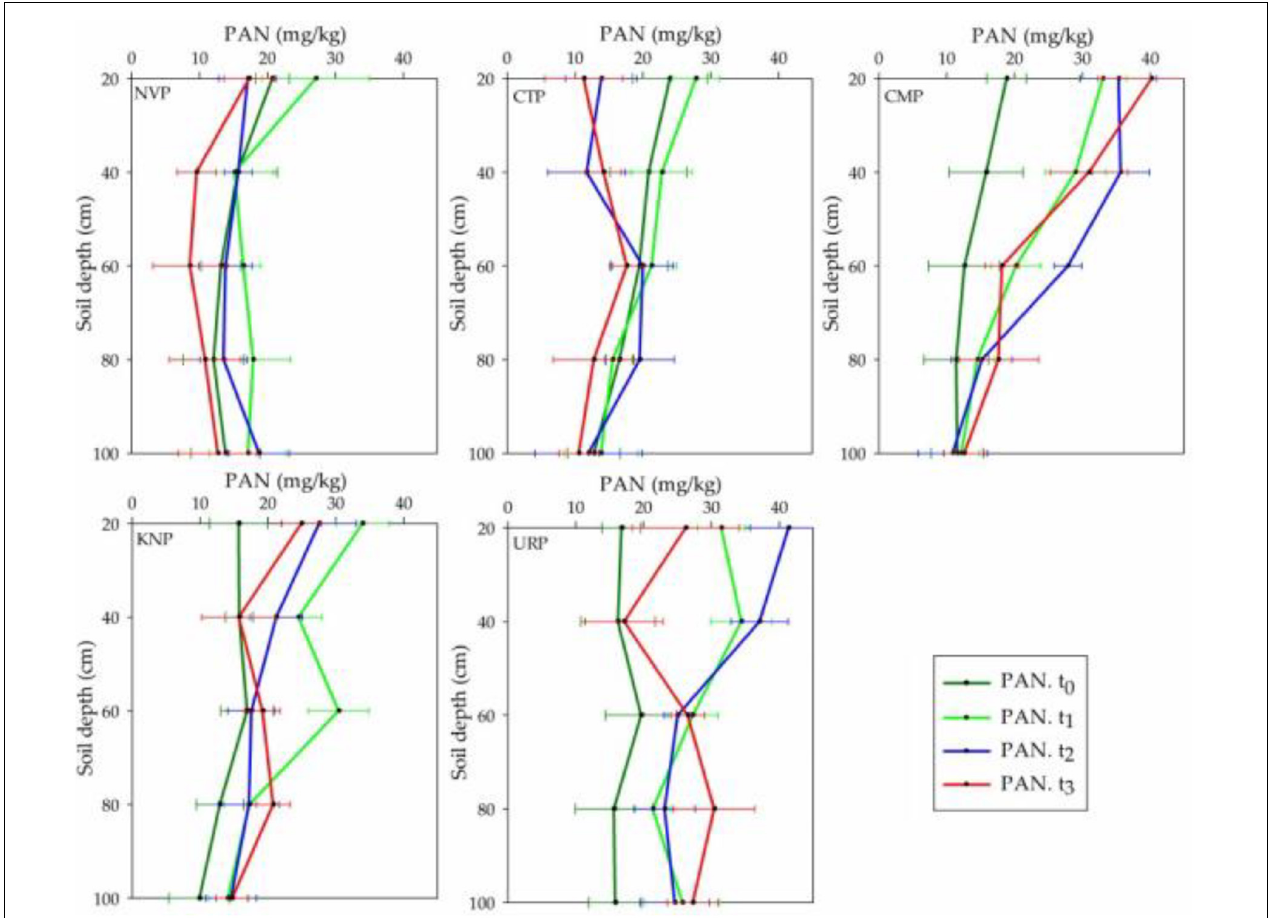
FIGURE 6 | Plant-available nitrogen (PAN) (nitrate + ammonium) variations in soil profile (0–100 cm) for the treatments NVP, CTP, CMP, KNP, and URP before fertilization (t 0 ) and after 1 month (t 1 ), 2 months (t 2 ), and 3 months (t 3 ) of fertilization during the Chinese cabbage production in Shunyi District,